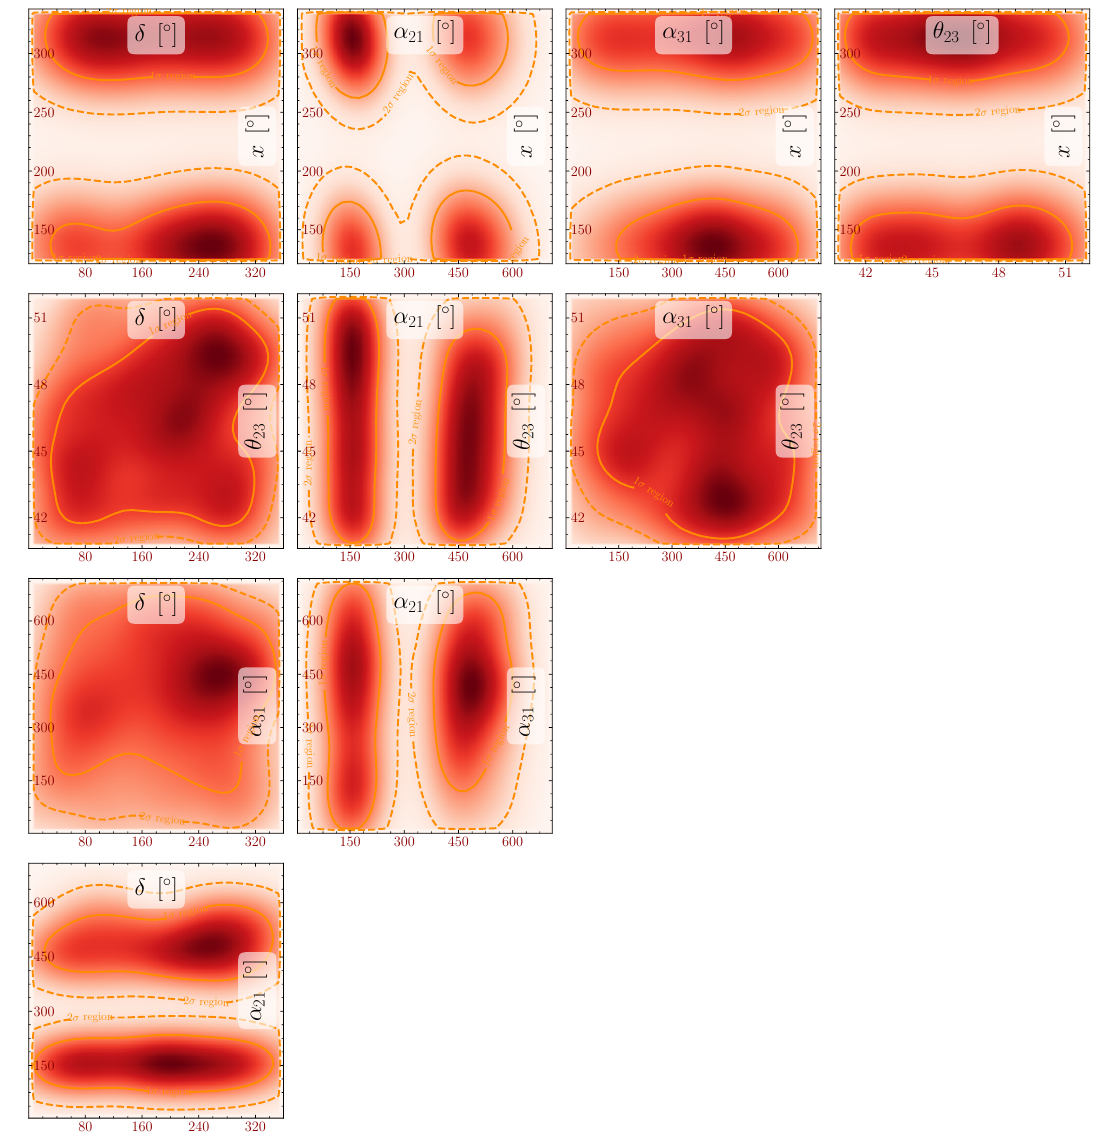
Figure 4 . The triangle plot shows regions of the model parameter space compatible with the mea- sured (cid:17) B within one and two (cid:27) for an inverted ordered mass spectrum using resonant leptogenesis with M = 2 : 4 10 6 GeV. The (cid:12)xed parameters were set to be y = 118 : 21 (cid:14) , (cid:18) 12 = 33 : 63 (cid:14) and (cid:2) (cid:18) 13 = 8 : 51 (cid:14) .